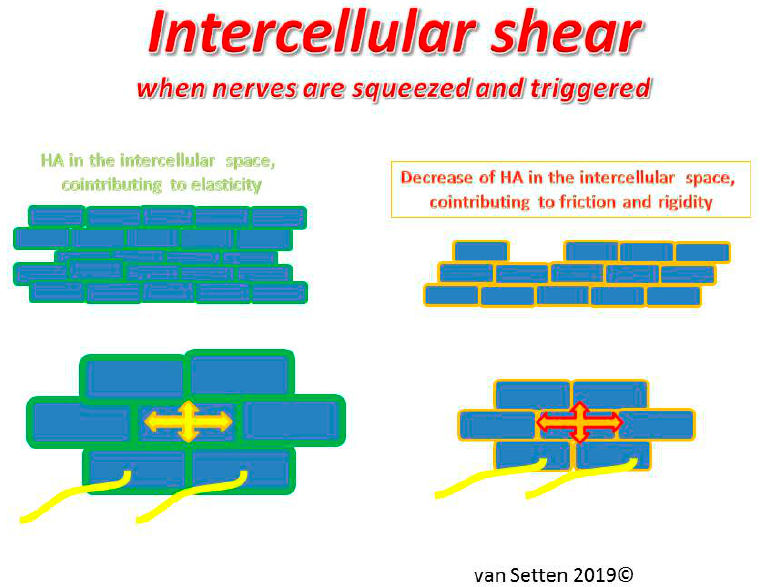
Figure 4. Illustrates the capacity and ease of cell movement and resilience in the normal epithelium in response to pressure in the presence of normal ECM.